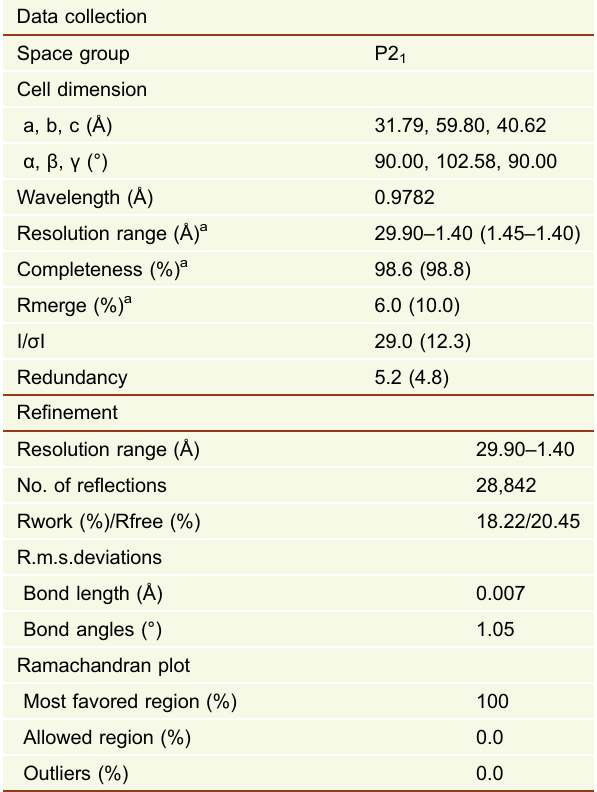
Table 1. Crystallographic statistics of MRG701